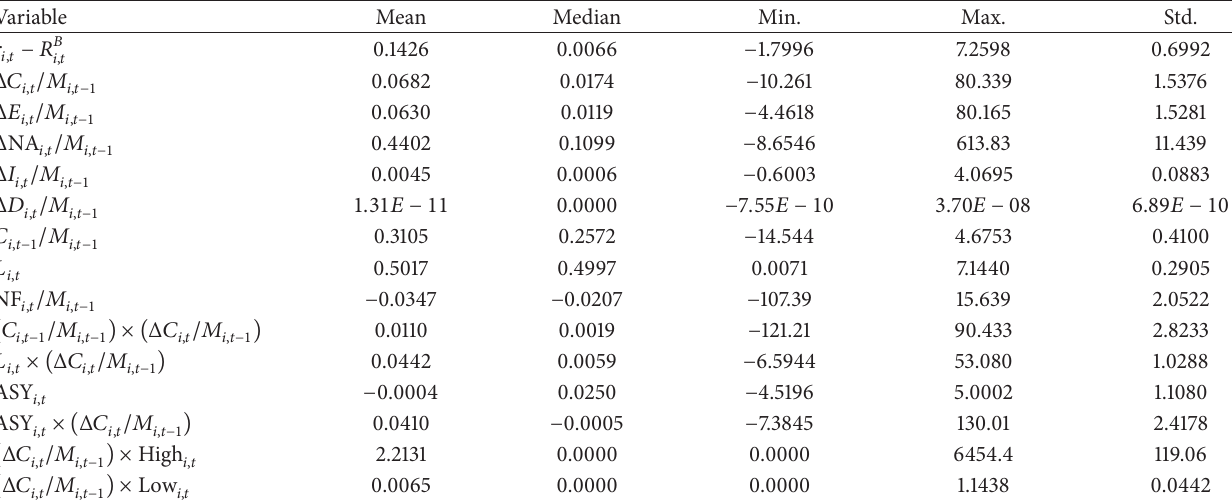
Table 4: Descriptive statistics of major variables.